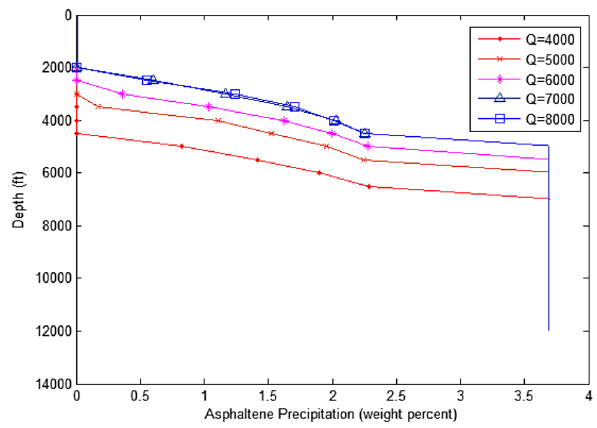
Fig. 16 Sensitivity analysis; effect of production rate on precipitation